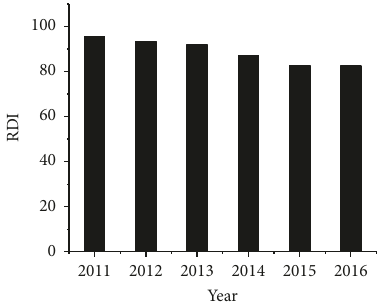
Figure 3: Continuous chart of the rutting depth index.